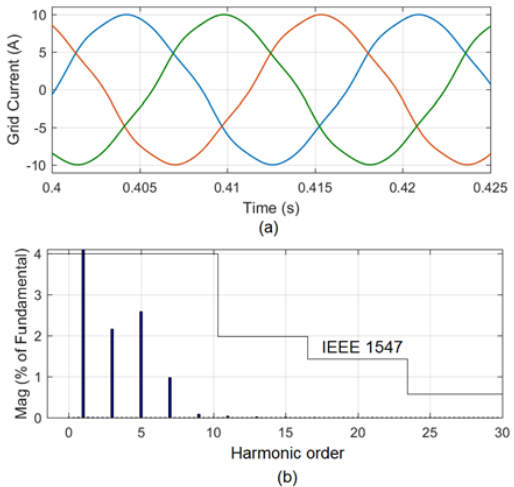
Figure 9. Three-phase grid current waveform and the respective harmonic spectra during distorted grid voltage and with L gmax for the proposed controller. Table 6. Comparing the distorted voltage grid’s THD using the suggested controller and the H∞ controller at L gmin and L gmax .